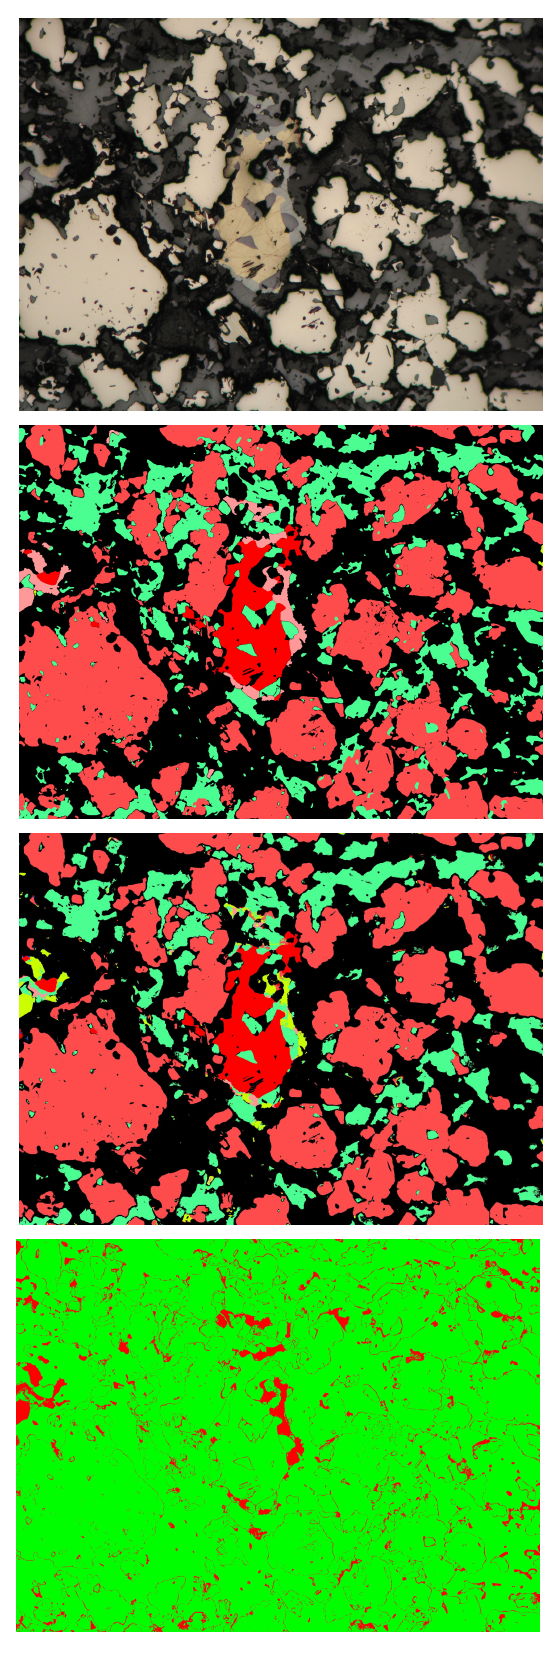
Figure 5. The result on one of the images from test subset of LumenStone S1. Up to down: source image, ground-truth mask, predicted mask, error